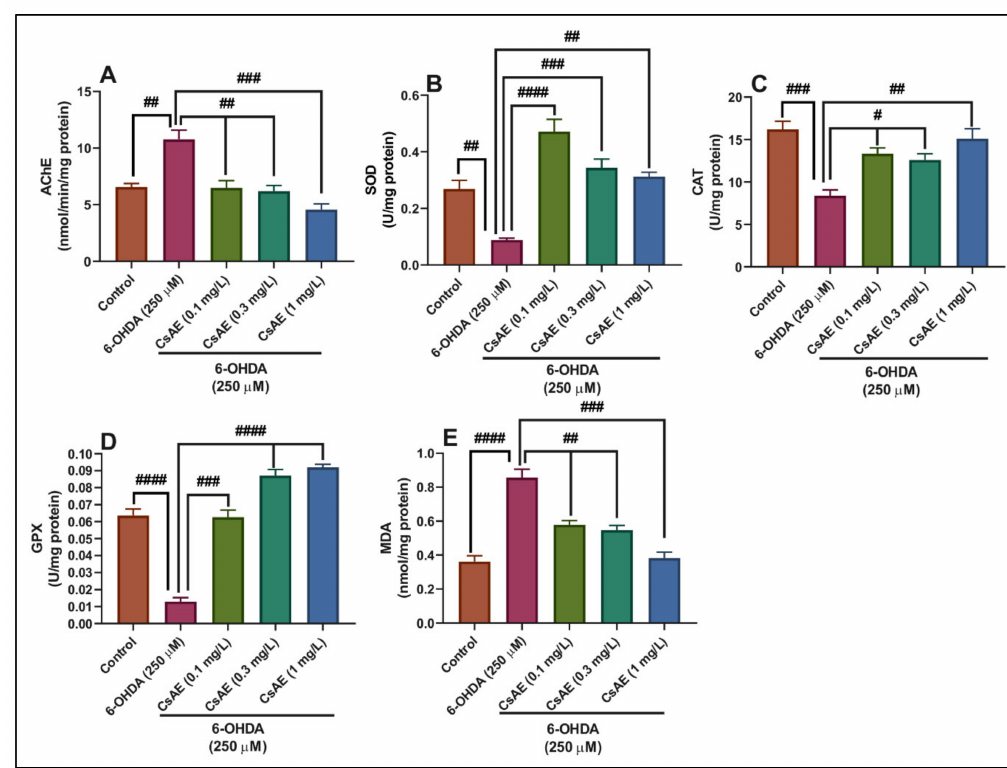
Figure 6. Ceratonia siliqua aqueous extract (CsAE, 0.1, 0.3, and 1 mg / L) exhibited an anti-AChE e ff ect and improved brain antioxidant status. The enzyme’s specific activities: ( A ) Acetylcholinesterase (AChE), ( B ) Superoxide dismutase (SOD), ( C ) Catalase (CAT), and ( D ) Glutathione peroxidase (GPX) and ( E ) Malondialdehyde (MDA) level. Values are means ± S.E.M. ( n = 10). For Tukey’s post